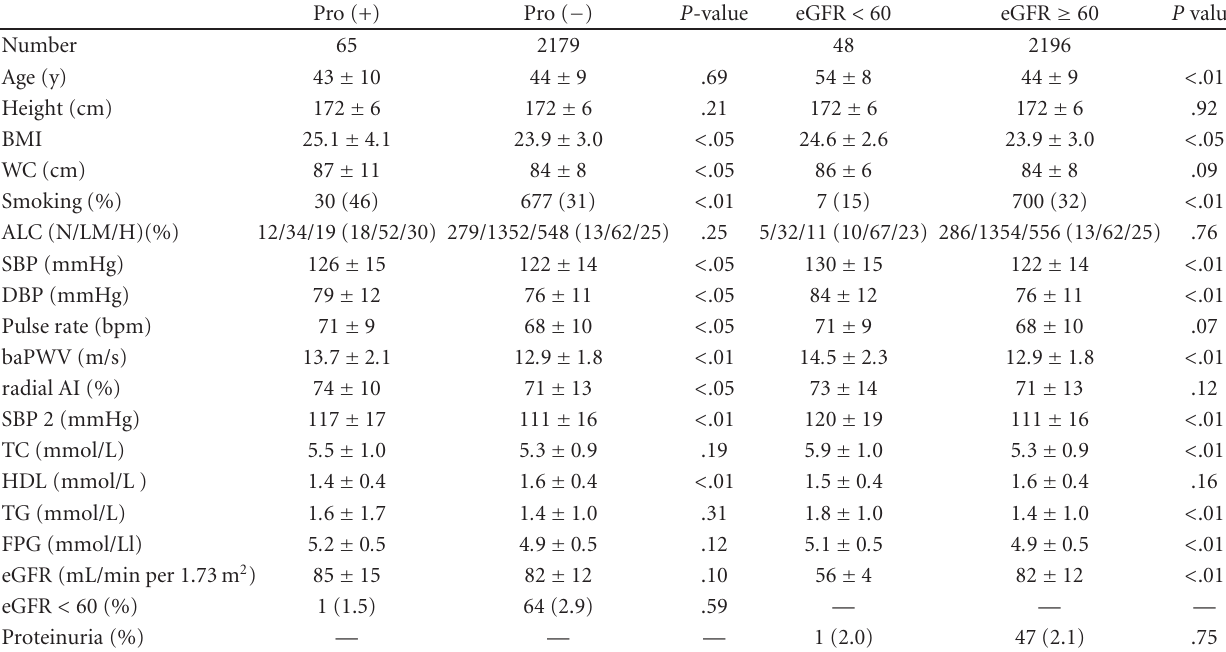
Table 2: Clinical characteristics of the study subjects classified by the presence/absence of